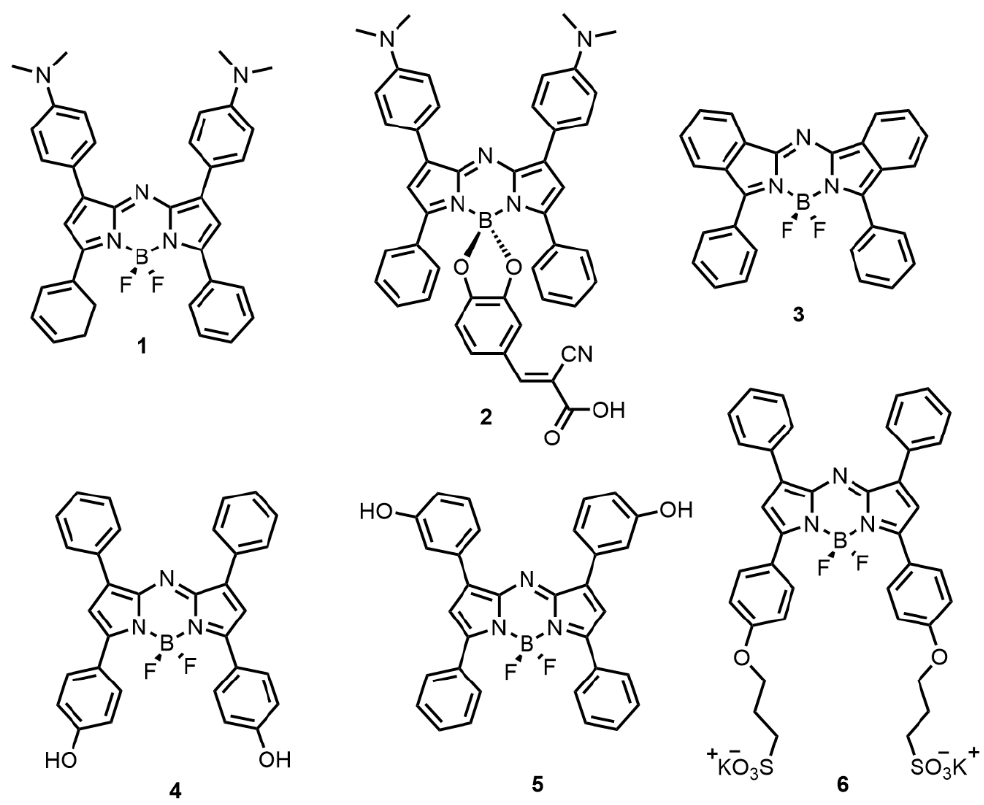
Figure 2. Structure of the aza-BODIPY-based and structurally related fluorophores (synthesis methods